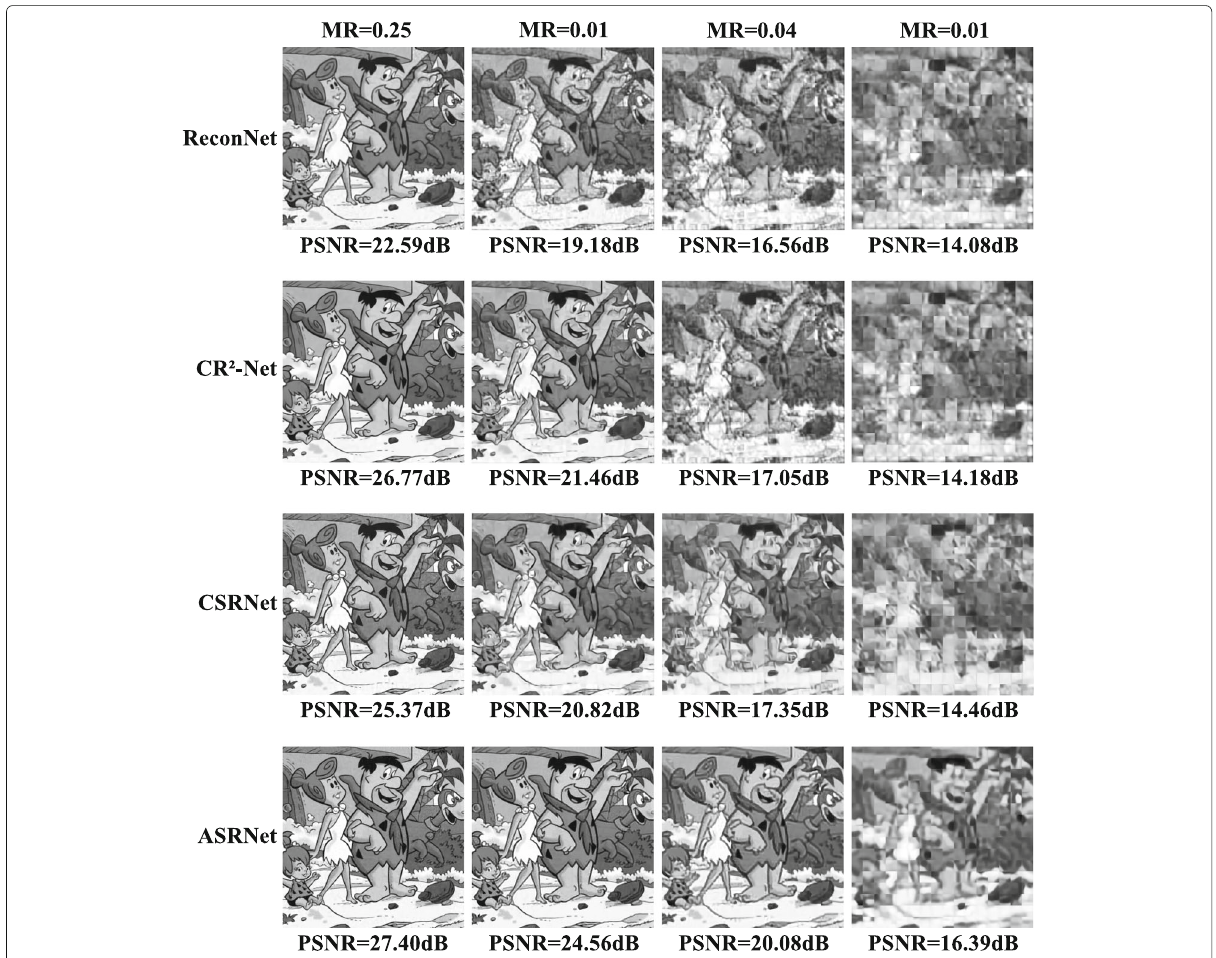
Fig. 16 The reconstruction results of Flinstones at the measurement rate of 0.25, 0.1, 0.04, and 0.01 with BM3D